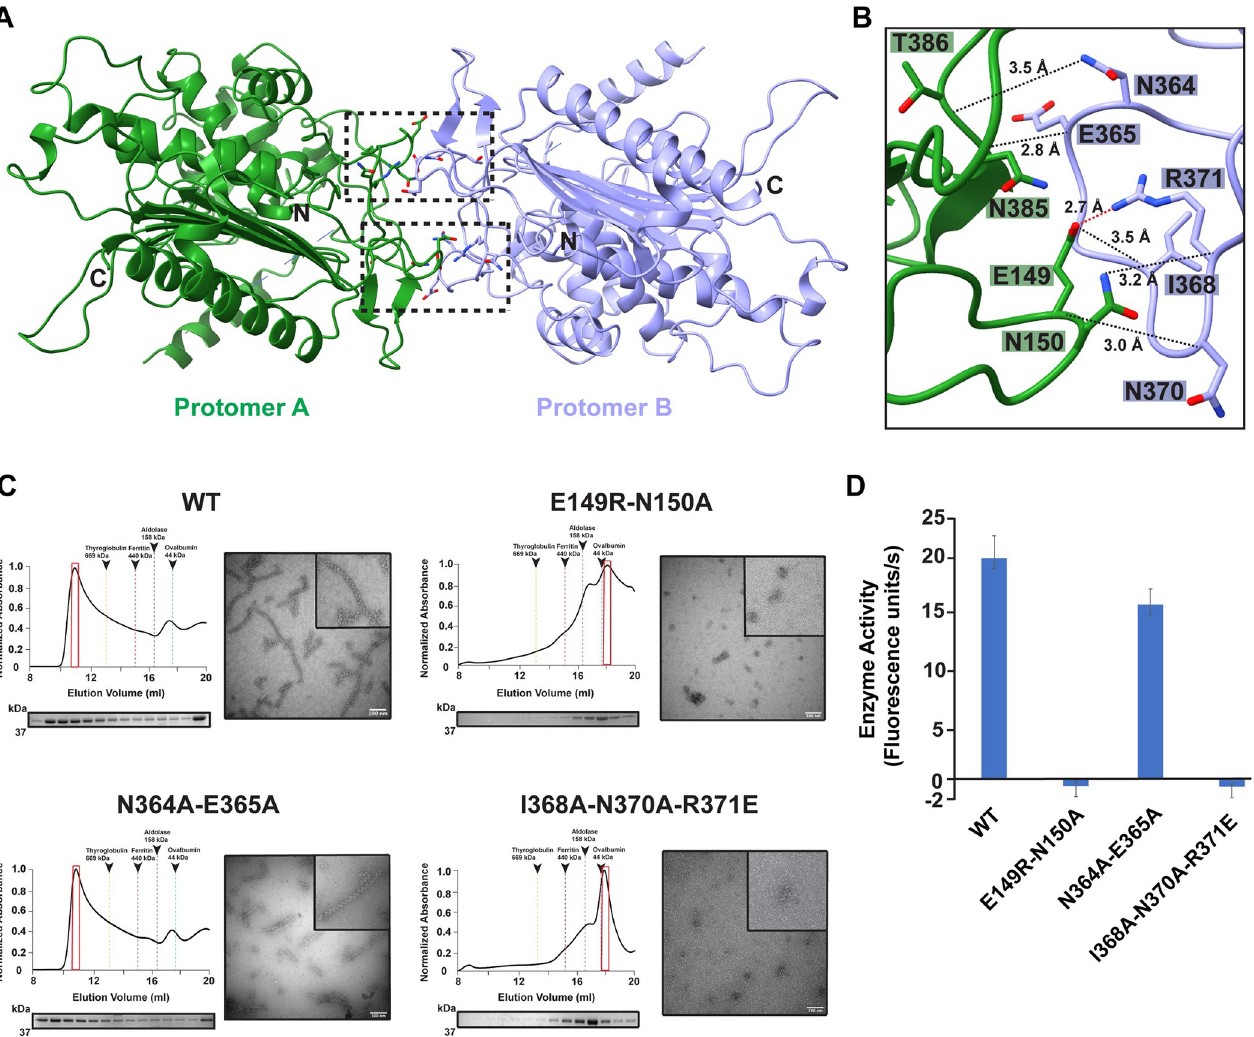
Fig 3. Structural characterization of LACTB dimerization interface. ( A ) LACTB protomers (colored in green and lilac) form an antiparallel dimer as shown in ribbon representation. Residues that are critical for oligomerization are represented in sticks. Black boxes indicate the position of dimer interface residues. ( B ) Zoomed in view of the black box in ( A ), showing the interactions that stabilize the dimer formation. The polar and charge–charge interactions are indicated by black and red dotted lines, respectively. ( C ) SEC elution profiles of WT and mutant LACTB. SEC elution profiles begin with the void volume (V 0 ) of the column. Fractions were analyzed by SDS-PAGE and peak fractions used in negative-stain TEM analyses are highlighted with red boxes. Negative-stain TEM images demonstrate the polymerization activity of WT and mutant proteins. Scale bars, 100 nm. ( D ) Mutation of key residues involved in dimerization disrupts catalytic activity. Enzyme activity was determined in vitro by using a fluorescently labeled substrate and 3 independent experiments were performed for each sample. Bars represent the mean of at least 3 independent experiments and error bars represent the standard deviation. The underlying data in ( D ) is provided in sheet Fig 3D in S1 Data. SEC, size-exclusion chromatography; TEM, transmission electron microscopy; WT,